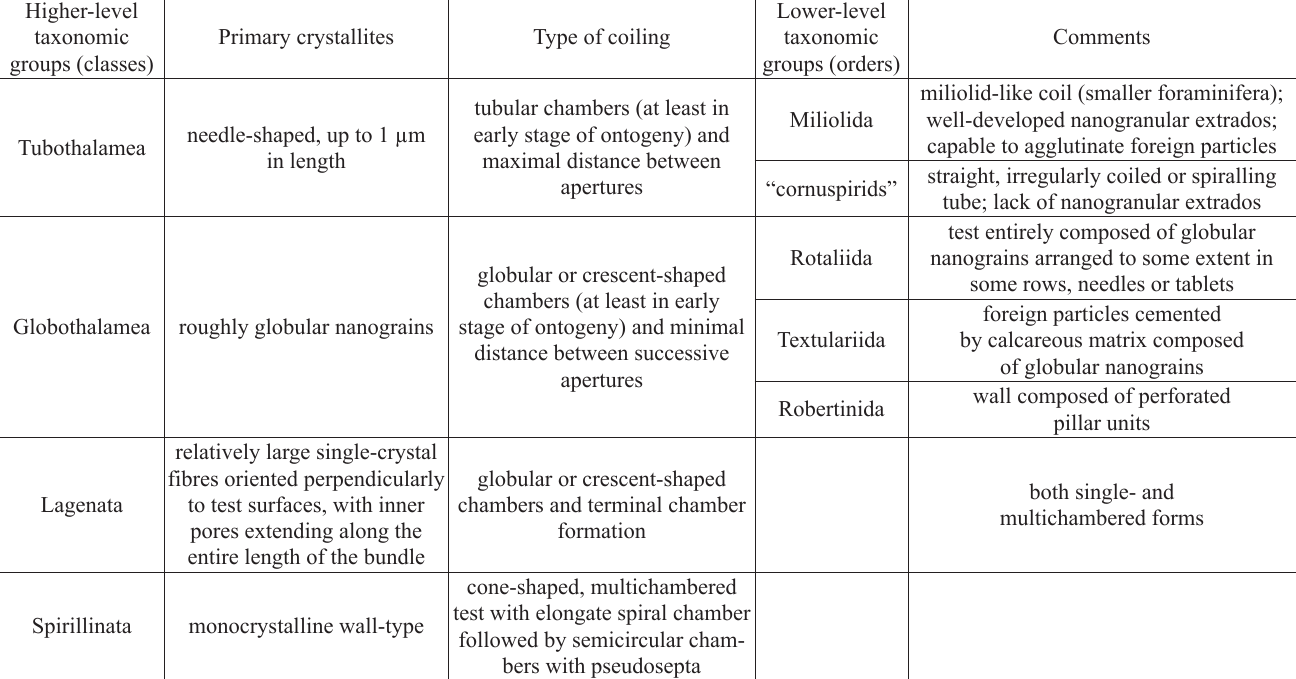
Table 1. Foraminiferal classification based on ultra-structural characteristic of the test.